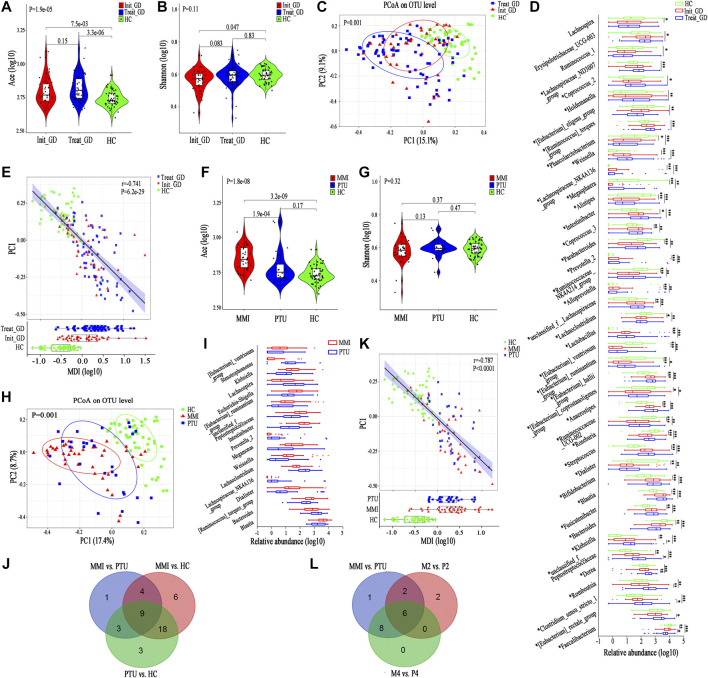
Shift in the gut microbiota diversity and structure after ATDs administration. (A,B) Violin plot of the alpha diversity indexes for richness (Ace index) and evenness (Shannon index) of the gut microbiota among the Init_GD, Treat_GD, and HC groups. (C) PCoA based on the Bray-Curtis distance showing different clusters among the three groups (p = 0.001). (D) Comparisons of the relative abundances among differentially abundant genera by Kruskal-Wallis H test (p < 0.05). (E) The MDI in the three groups and spearman correlation between the MDI and PC1 of the PCoA. The MDI is defined as the log of [total abundance among genera increased in Init_GD or Treat_GD] divided by [total abundance among genera decreased in Init_GD or Treat_GD]. (F,G) Violin plot of the alpha diversity Ace index and Shannon index of the gut microbiota among the MMI, PTU and HC groups. (H) PCoA based on the Bray-Curtis distance showing different clusters among the MMI, PTU, and HC groups (p = 0.001). (I) Comparisons of the relative abundances among differentially abundant genera by Mann-Whitney U-tests (p < 0.05). (J) Venn diagram demonstrating the number of shared and specific differentially abundant genera of every pair of groups among the MMI, PTU, and HC groups. (K) The MDI in the MMI, PTU, and HC groups and spearman correlation between the MDI and PC1 of the PCoA. (L) Venn diagram demonstrating the number of shared and specific differentially abundant genera in the holistic comparison and corresponding specific time points between MMI and PTU. *p indicates a p value < 0.05 among the three groups, p* indicates a p value < 0.05 between each pair of groups. *p value < 0.05; **p value < 0.01; ***p value < 0.001.